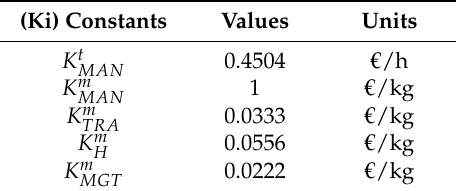
Table 9. (Ki) constants associated to the different cost factors, calculated for the 2017 inventory figures at Unistral Recambios